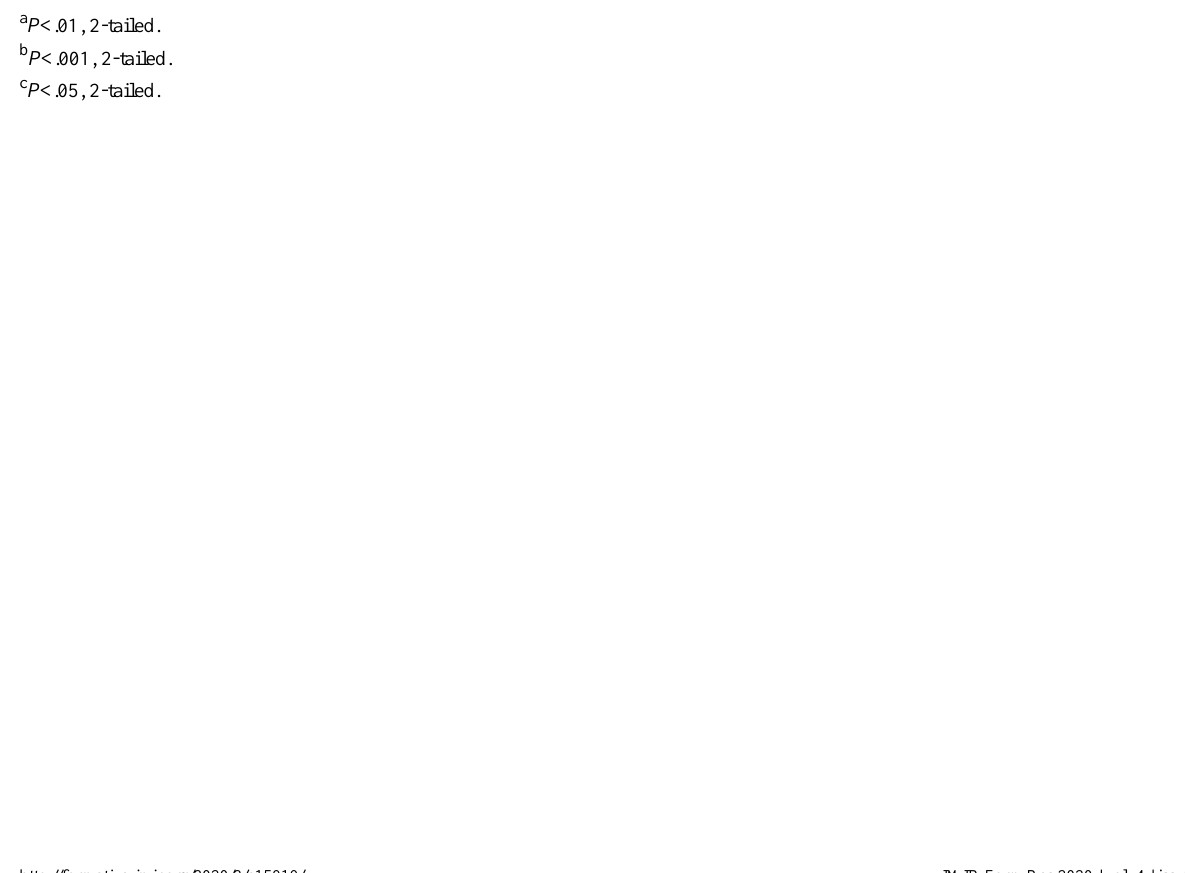
Table 3. The paragraphs below briefly interpret these estimates with regard to the corresponding hypothesis tested.